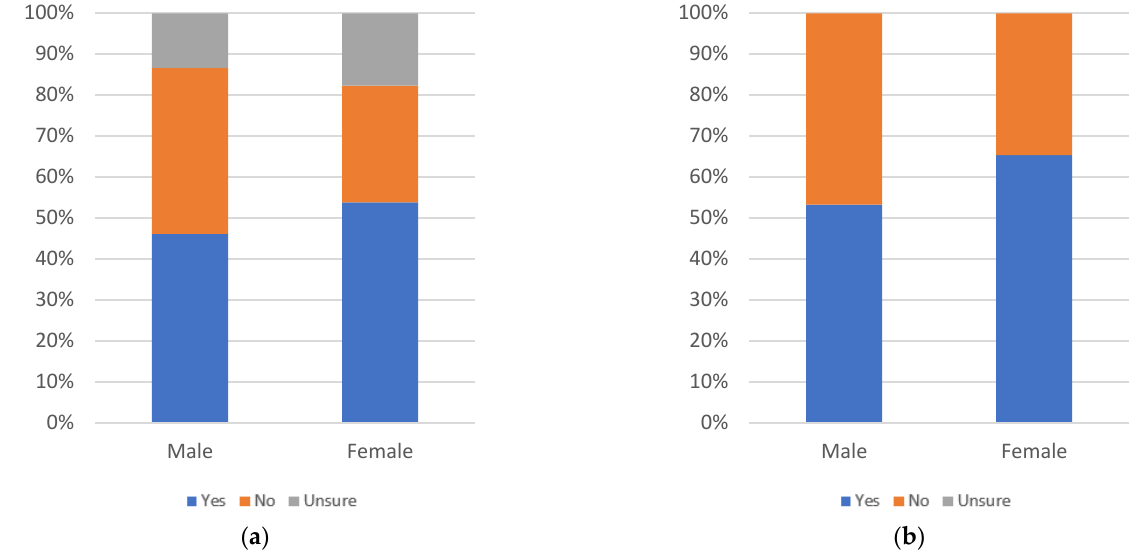
Figure 109. Label use, by gender: ( a ) with uncertain respondents (left) and ( b ) without uncertain respondents (right).